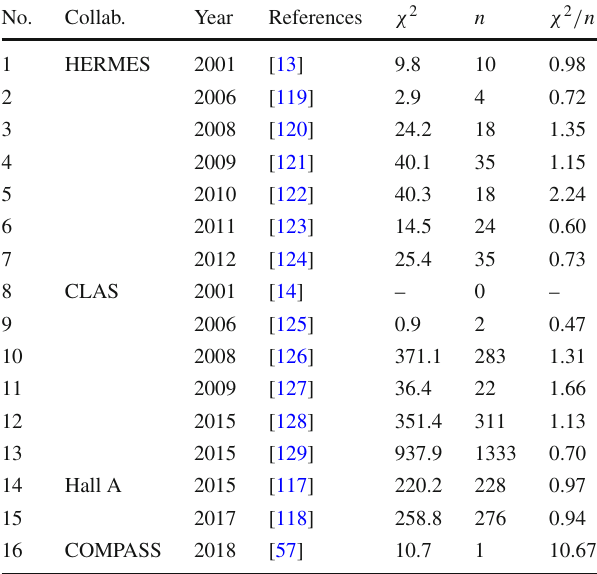
Table 4 Values of the χ 2 function per data set. For a given data set, cf. Table 3, given are: χ 2 value, the number of experimental points n , and the ratio between these two numbers No. Collab.